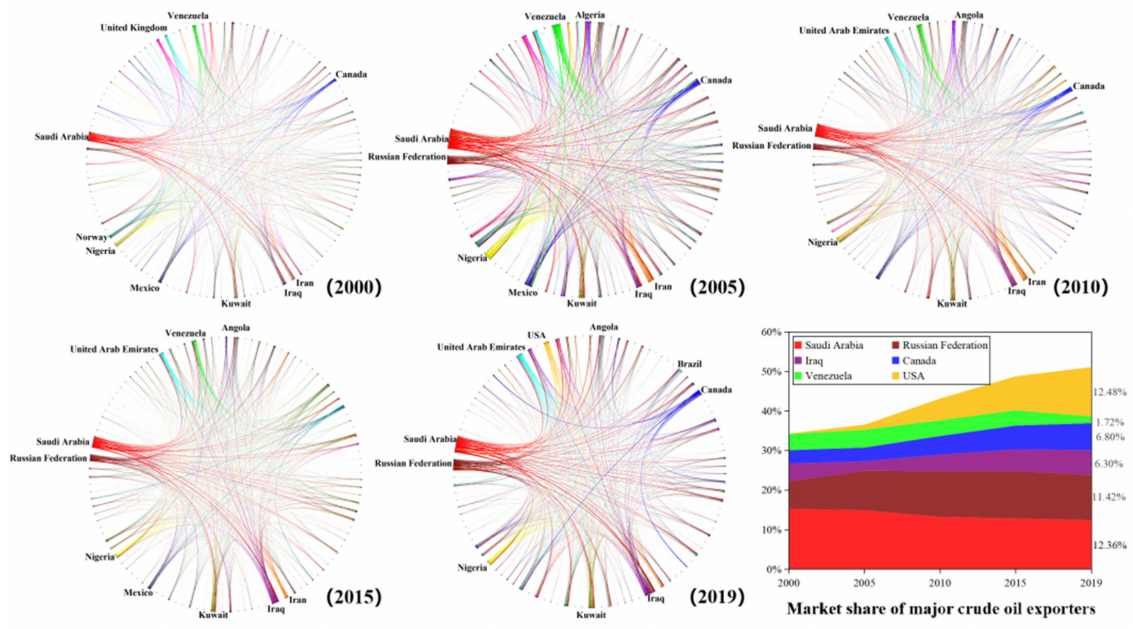
Figure 4. The evolution of competition among exporters from 2000 to